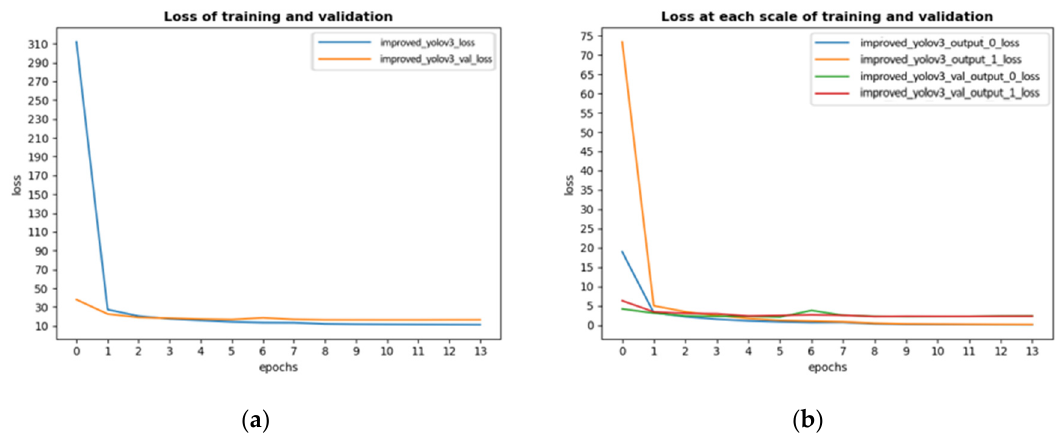
Figure 7. Convergence process of loss of standard Yolov3. ( a ) showed the training and validation loss of standard Yolov3. ( b ) showed the training and validation loss of standard Yolov3 at each scale. In Figure 7b, the ‘0’ in ‘output_0_loss’ means the loss at 13 × 13 scale; the ‘1’ in ‘output_1_loss’ means the loss at 26 × 26 scale.